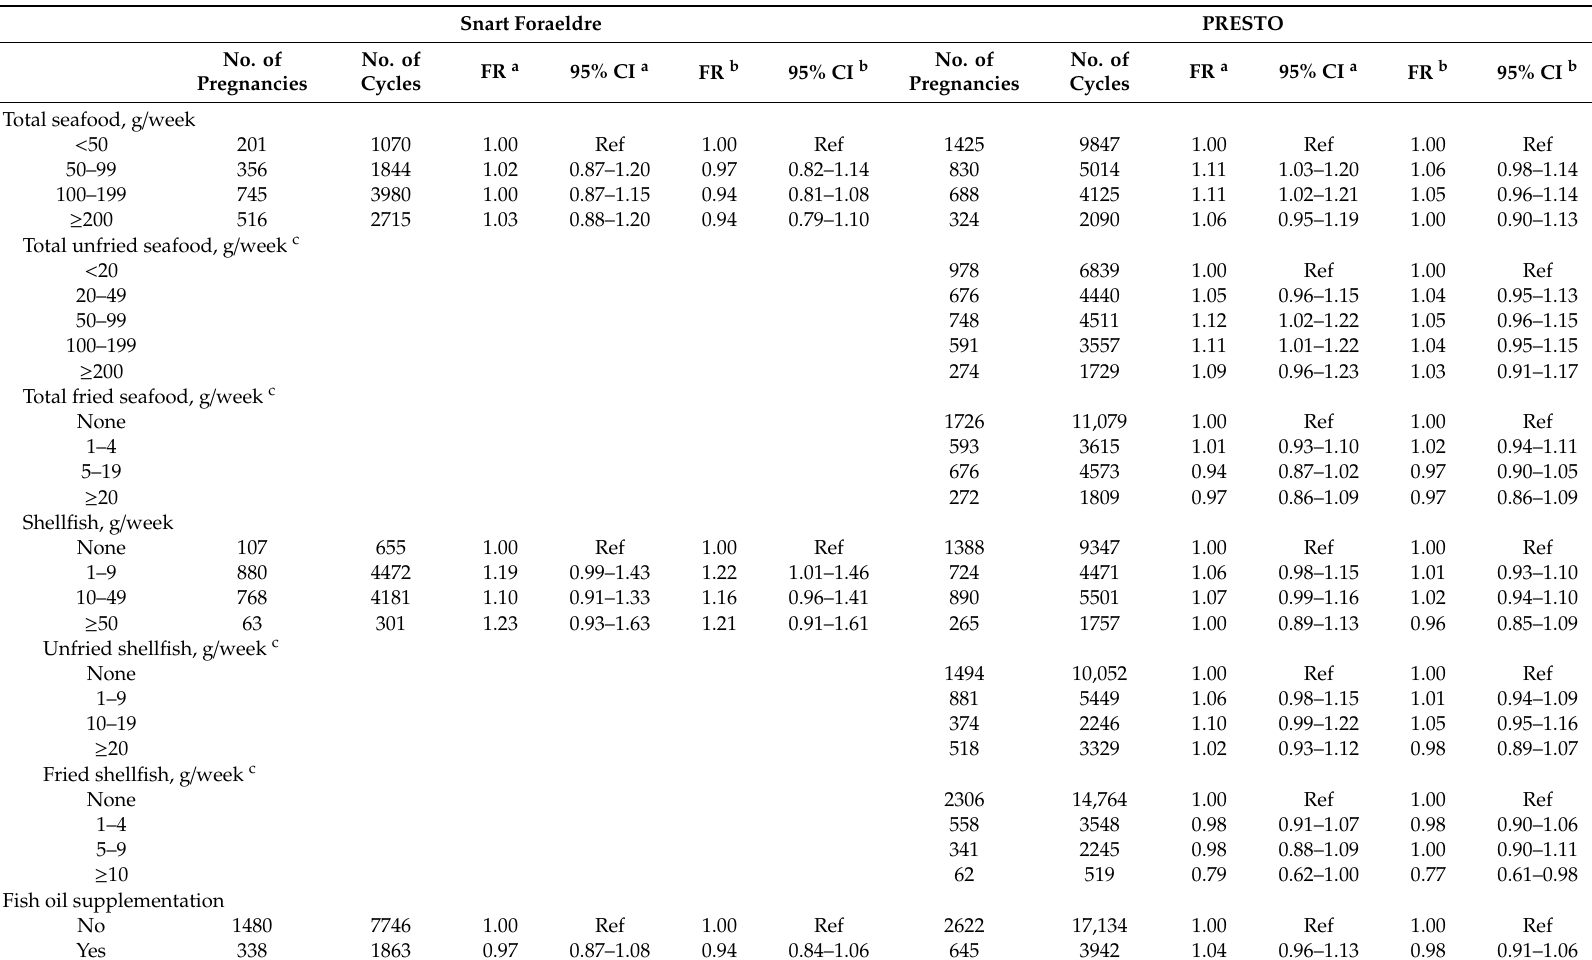
Table 2. Association between seafood intake and fecundability, Snart Foraeldre and PRESTO